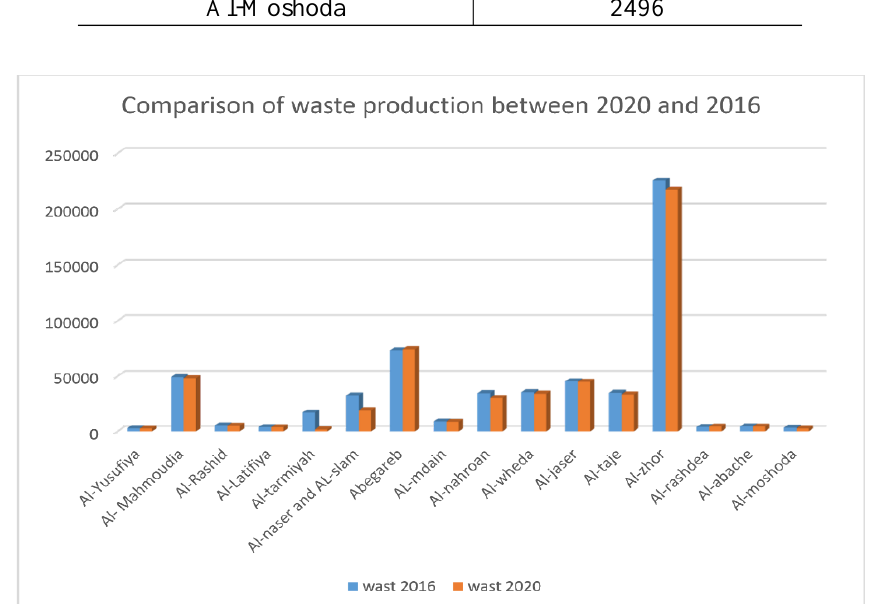
Figure 2: Waste producing statistics.